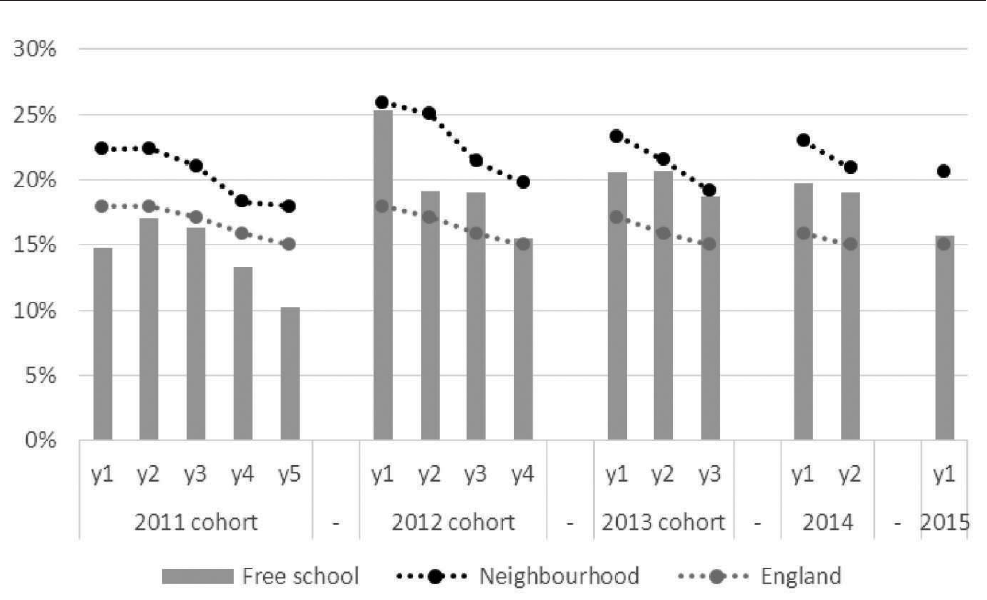
Figure 6: Pupils eligible for FSM at secondary free schools in Year 7 compared to their